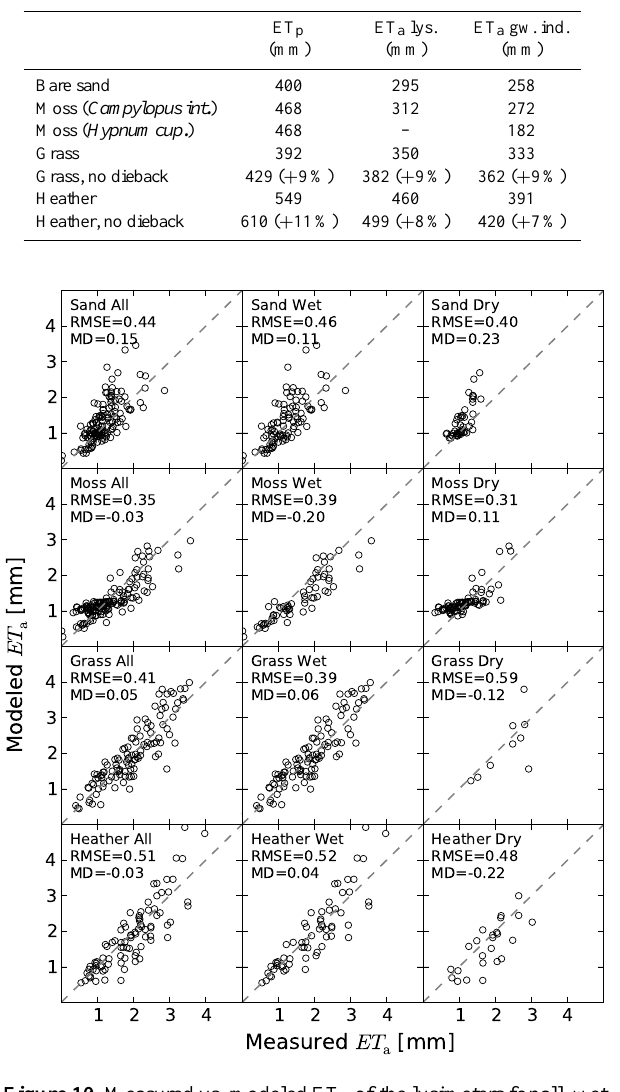
Figure 10. Measured vs. modeled ET a of the lysimeters for all, wet (ET a,mod = ET p ) and dry (ET a,mod (cid:54)= ET p ) days. Dotted lines rep- resent the 1 : 1